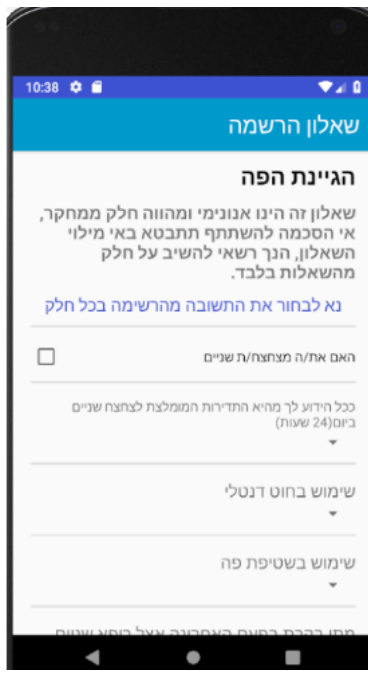
Figure 9. Registration questionnaire screen for the patient: oral hygiene.